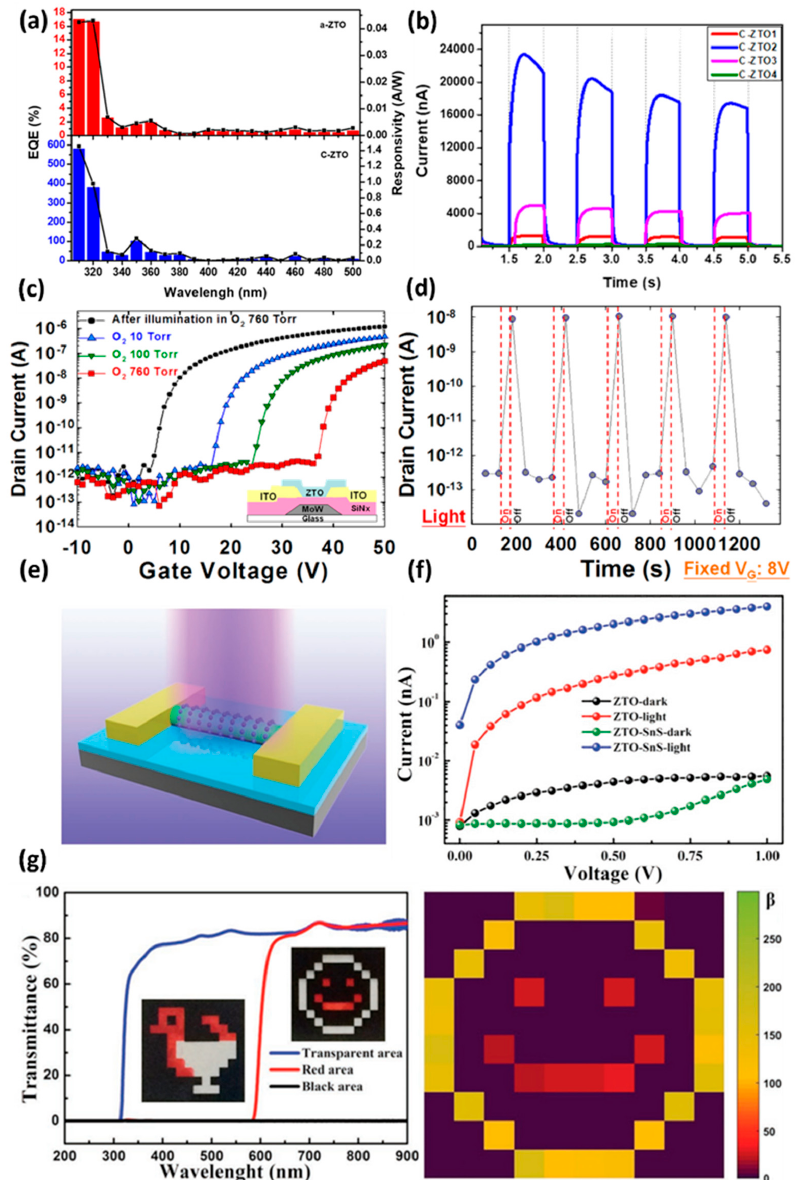
Figure 6. ( a ) Photon-to-electron conversion efficiency according to the crystallinity of the fabricated a-ZTO-MS and c-ZTO-MS and the wavelength of the irradiated light. ( b ) I-V characteristics of photocurrent difference of c-ZTO-MS monolayers with varied MS diameters at a UV wavelength of 254 nm. The MS has diameters of 1.51 µ m, 1.24 µ m, 0.99 µ m, and 0.79 µ m, respectively (adapted from [87] with permission from American Chemical Society). ( c ) Transfer characteristics of the fabricated ZTO TFTs in different oxygen partial pressures (10 torr, 100 torr, and 760 torr) and after illumination of visible light, respectively. ( d ) Repeated oxygen adsorption/desorption cycle depending on light irradiation, the I DS decreases upon the adsorption of oxygen and increases upon the desorption of oxygen by visible light (the fixed gate voltage of 8 V and drain voltage at 1 V) (adapted from [97] with permission from AIP Publishing). ( e ) Schematic diagram of ZTO NW and a SnS QDs decorated photodetector fabricated on SiO 2 /Si substrate. ( f ) I-V curve of photodetectors made of a pristine ZTO NW and ZTO NW decorated with SnS QDs under 300 nm UV illumination. ( g ) The flexible ZTO NW-based 10 × 10 image sensor array fabricated on a PET substrate and decorated with SnS QDs can detect bicolors, as shown in the image below (adapted from [98] with permission from John Wiley and